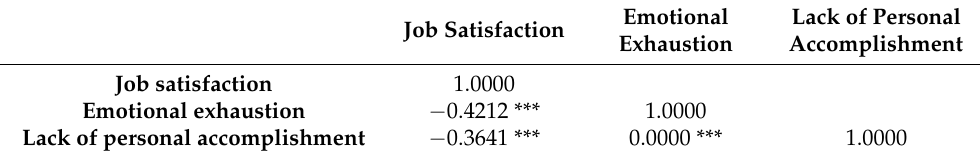
Table 8. Correlation and significance between job satisfaction and burnout. Emotional Lack of Personal Job Satisfaction Exhaustion Accomplishment Job satisfaction 1.0000 Emotional exhaustion − 0.4212 *** 1.0000 Lack of personal accomplishment − 0.3641 *** 0.0000 *** 1.0000 *** p <